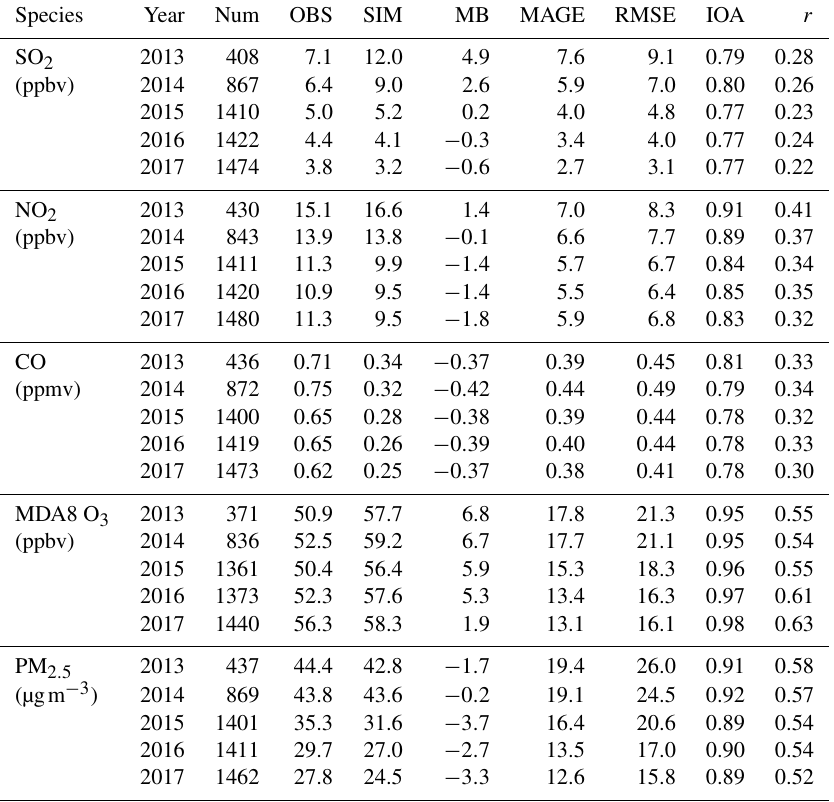
Table 2. Evaluation results for the air pollutants in China (Num is number of sites with available observation for statistics; OBS is mean observation; SIM is mean simulation; MB is mean bias; MAGE is mean absolute gross error; RMSE is root mean square error; IOA is index of agreement; r is correlation coefficient; OBS, SIM, MB, MAGE, and RMSE have the same units as given in the first column, while IOA and r have no